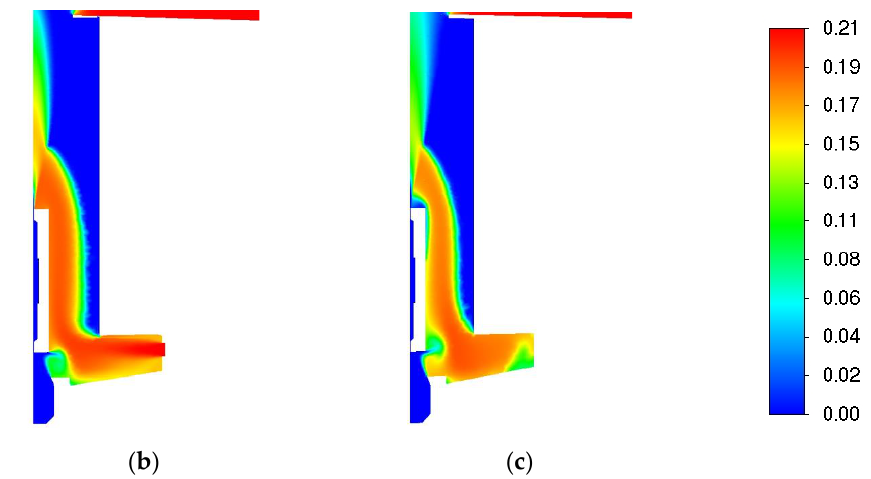
Figure 18. Volume fraction of O 2 : ( a ) 1 reaction EDC; ( b ) 60 reactions EDC; ( c ) 305 reactions EDC.